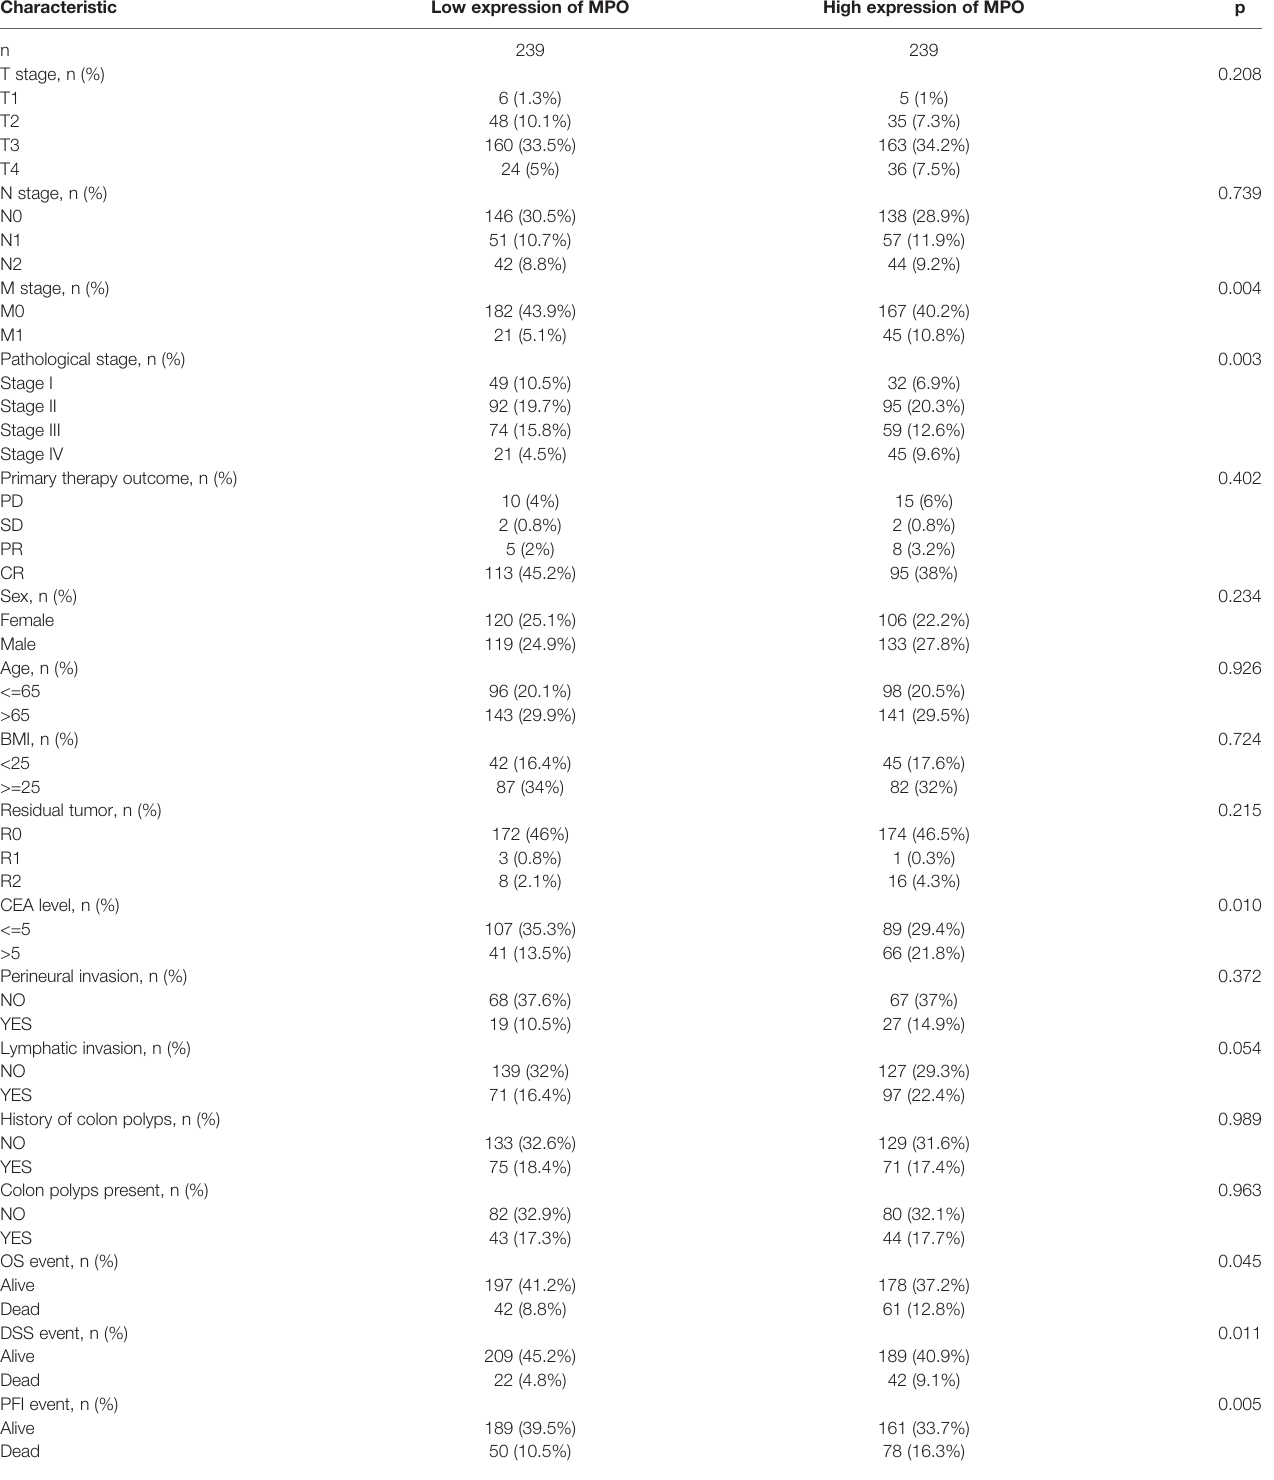
TABLE 1 | The relationship between MPO expression and the clinicopathological features of CRC in TCGA.